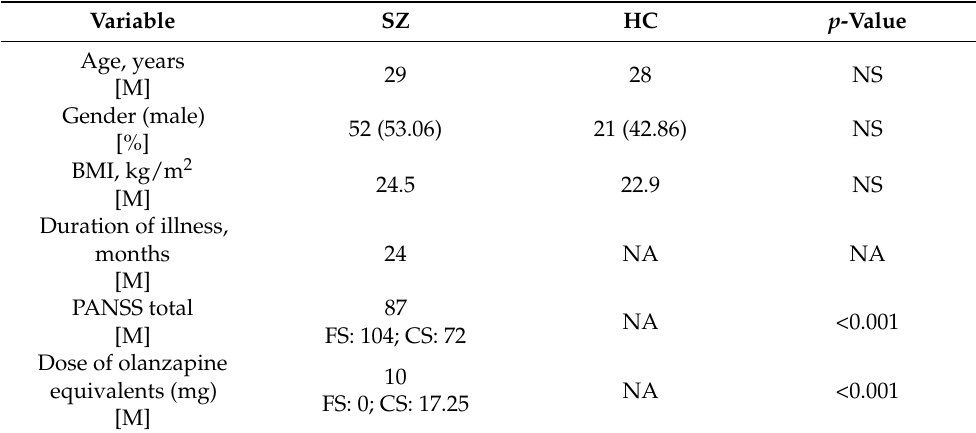
Table 1. Characteristics of examined